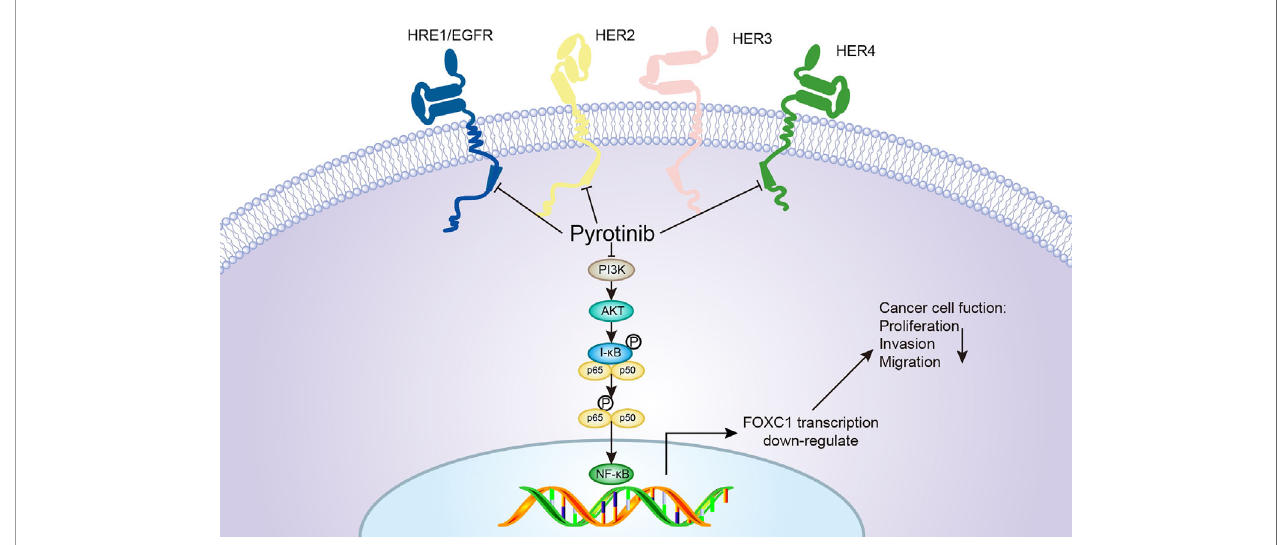
FIGURE 9 | A proposed model for the pyrotinib-mediated inhibitory effects on the apoptosis, migration, and invasion of BCs. Pyrotinib is an irreversible HER 1, 2, and 4 inhibitor that inhibits the downstream signals of the Akt/p-65/FOXC1 pathway, resulting in a signi fi cant ef fi cacy in cell proliferation, migration, and invasion of HER2-overexpressing cancer